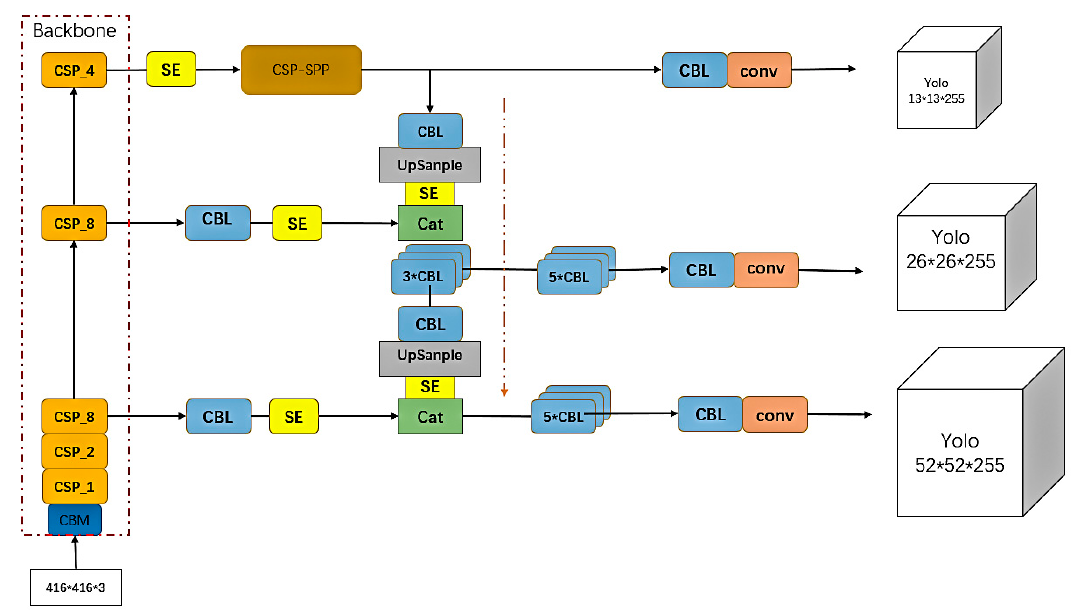
Figure 5. Improved YOLOv4 network.